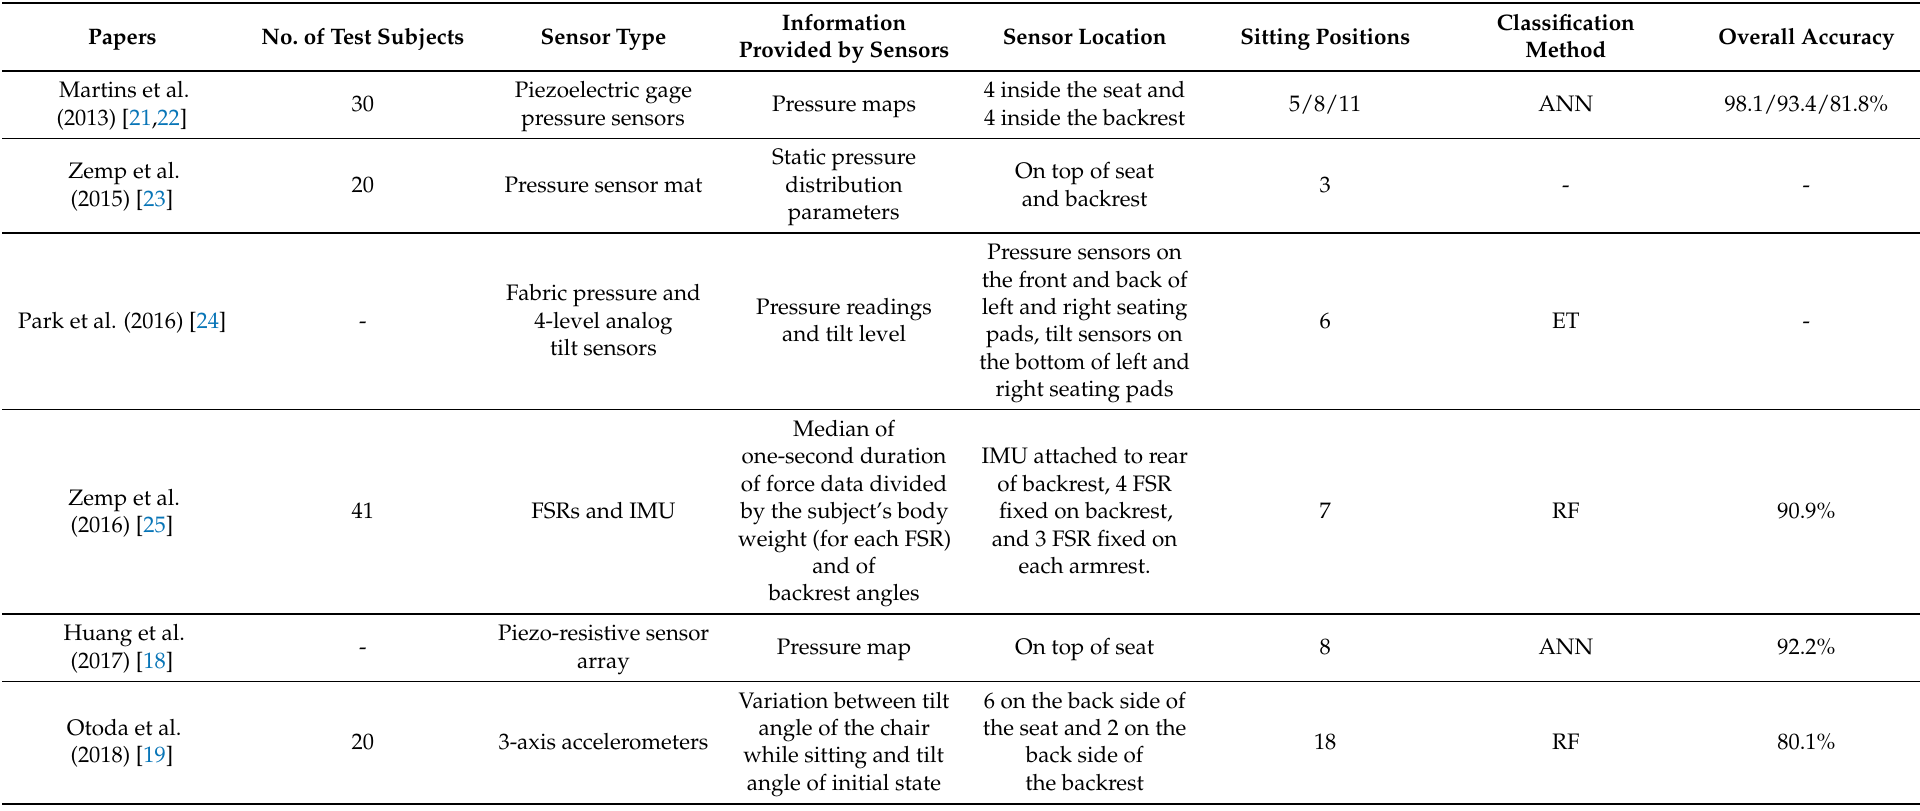
Table 1. Posture monitoring systems proposed in the